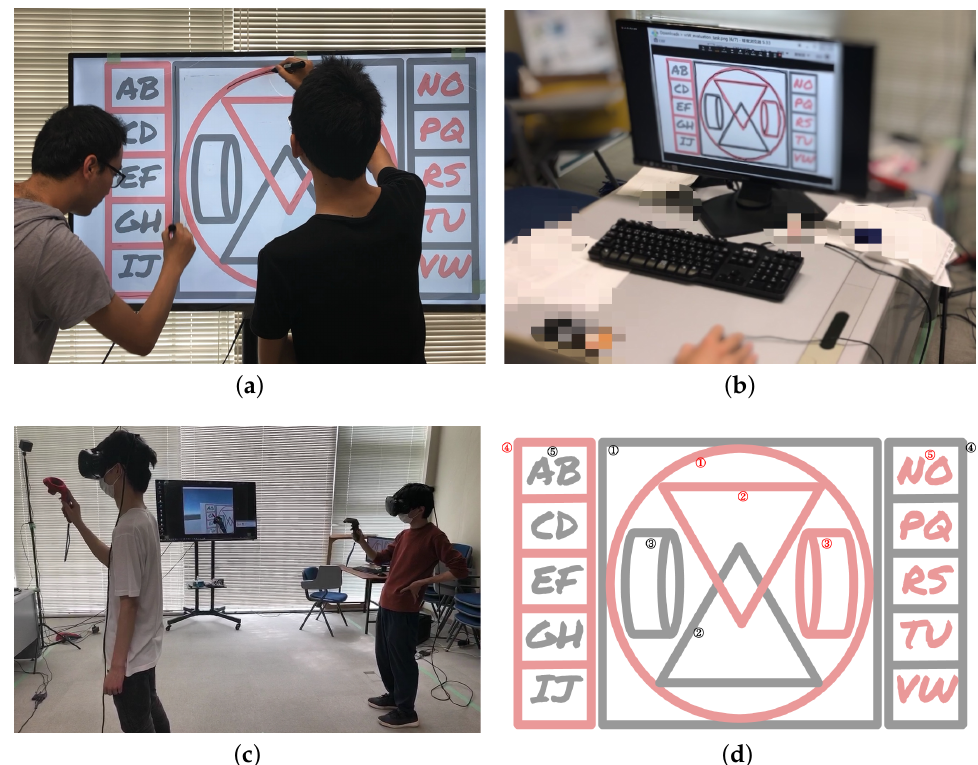
Figure 3. Collaboration efficiency experiment design regarding the three experiment scenes, including traditional whiteboard (pen), electronic whiteboard (mouse), and the proposed VR whiteboard. ( a ) Traditional whiteboard (pen) scene; ( b ) Electronic whiteboard (mouse) scene; ( c ) VR whiteboard scene; ( d ) Task for evaluation